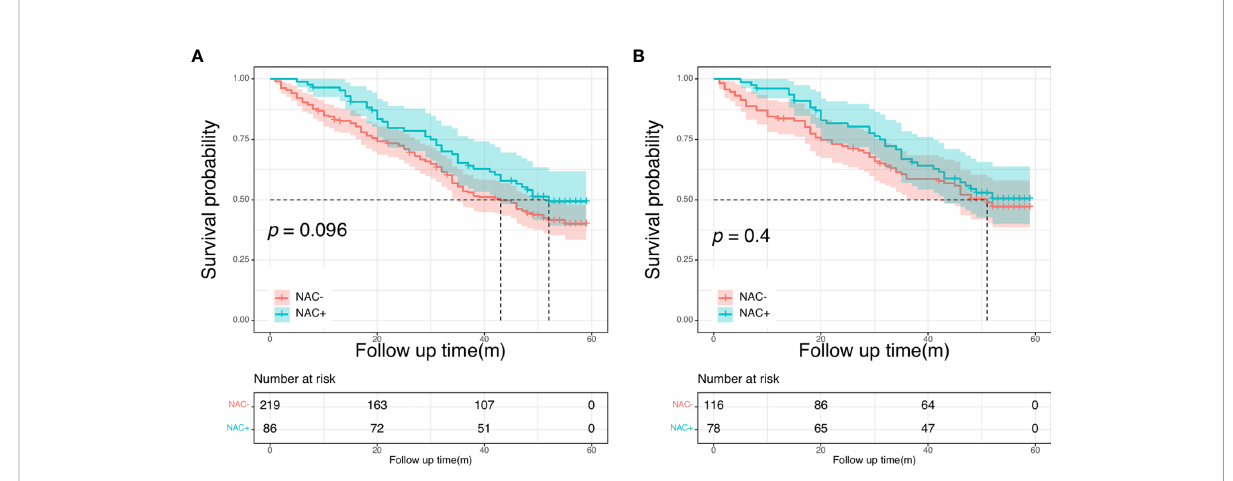
FIGURE 3 Overall survival curves in SEER cohort: in the entire cohort (A) ; in the propensity score-matched cohort (B) .